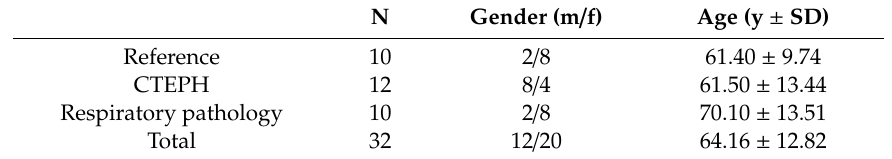
Table 2. Demographics of the study population (m, male; f, female; y, years; SD, standard